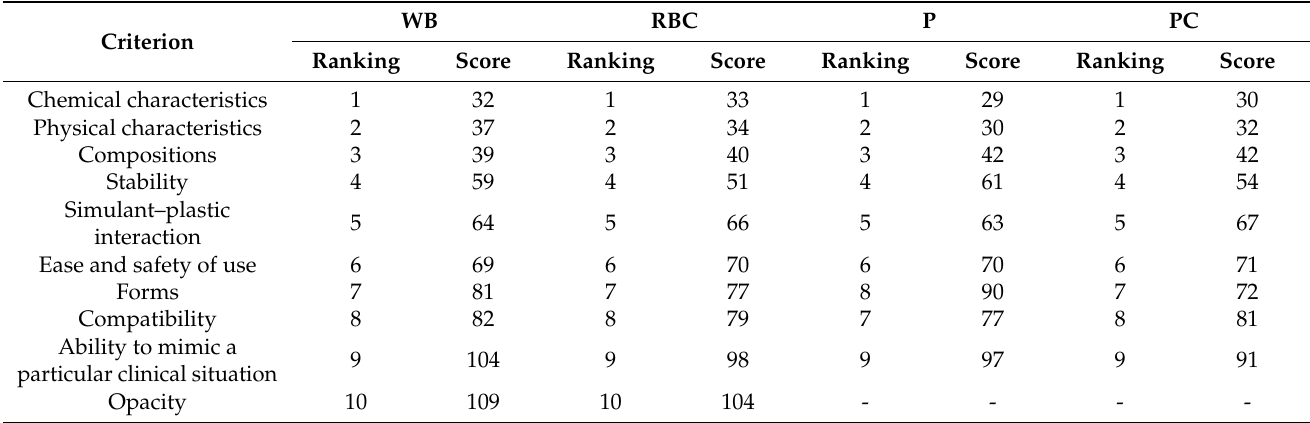
Table 5. Ranking of the criteria for each labile blood product.